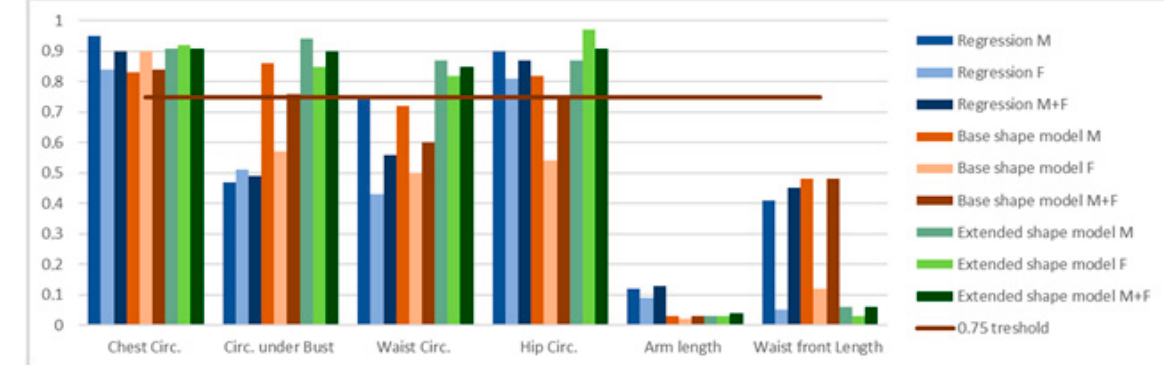
Figure 5. ICC values (higher is better) for all three methods in order for all measurements: Regression